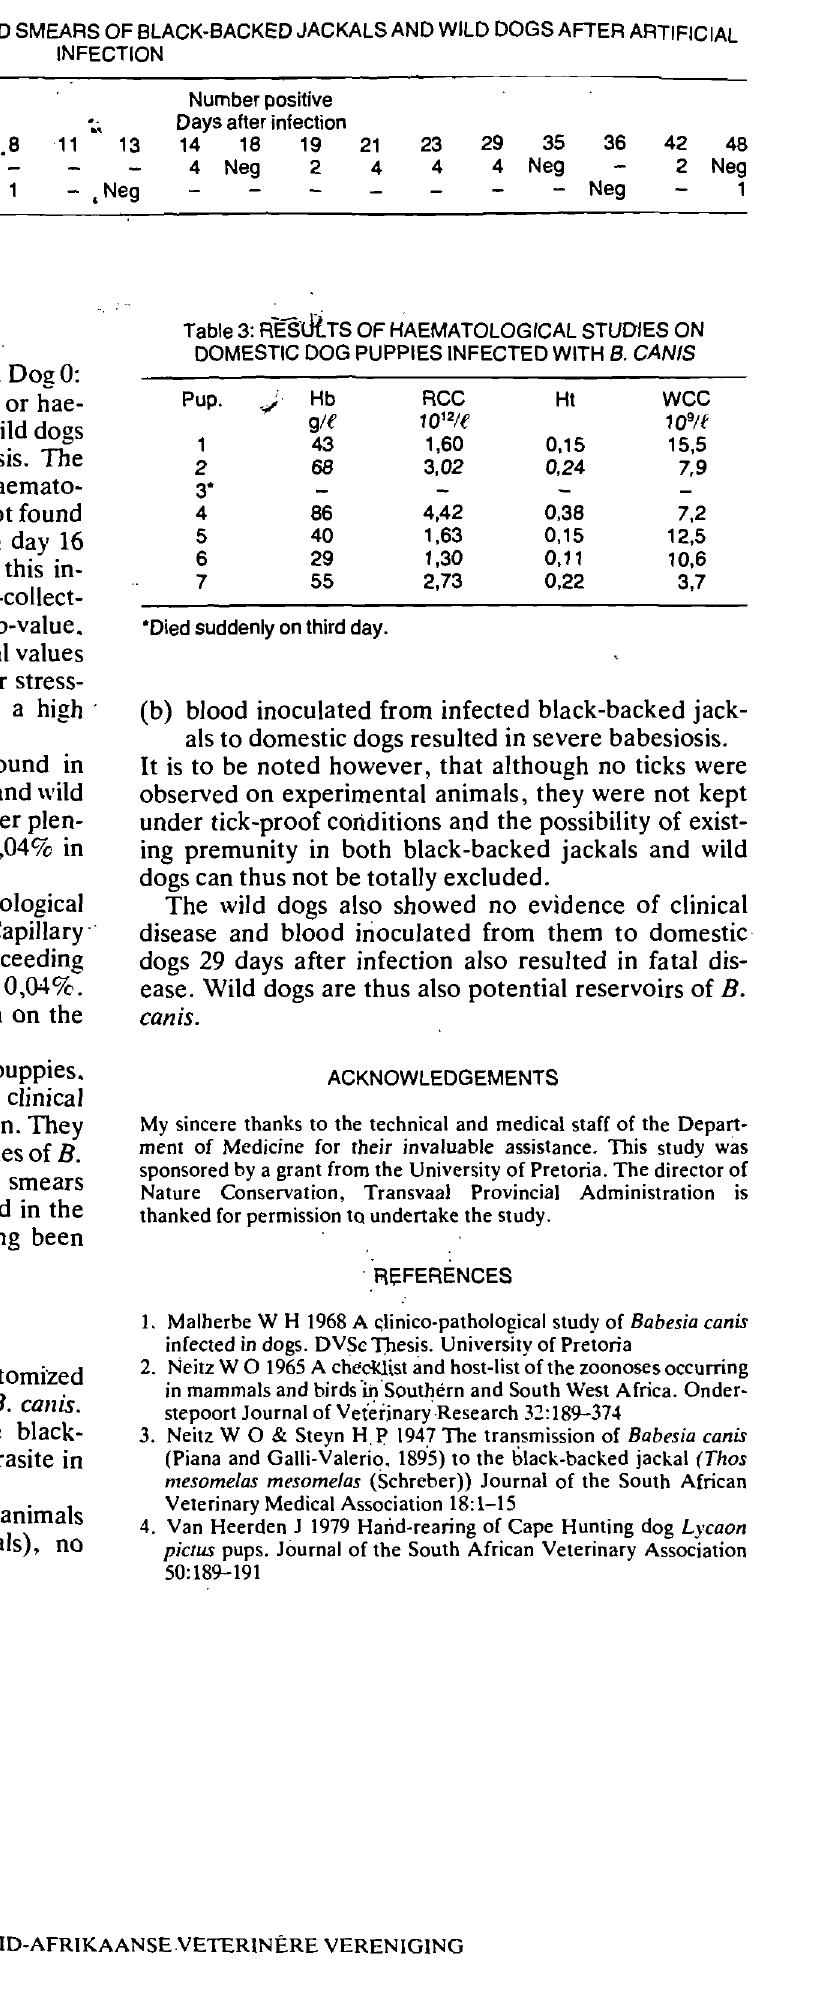
Table 2: PRESENCE OF BABESIA PARASITES IN BLOOD SMEARS OF BLACK-BACKED JACKALS AND WILD DOGS AFTER ARTIFICIAL INFECTION '. Number positive .. Animal Number Days after infection used 5 6 7 .8